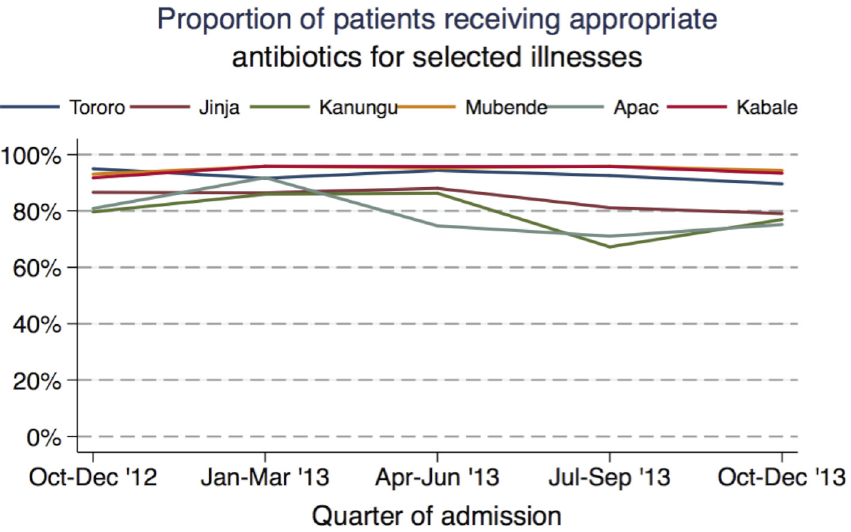
Fig 3. Trends in appropriate inpatient case management of selected illnesses requiring antibiotics, by health